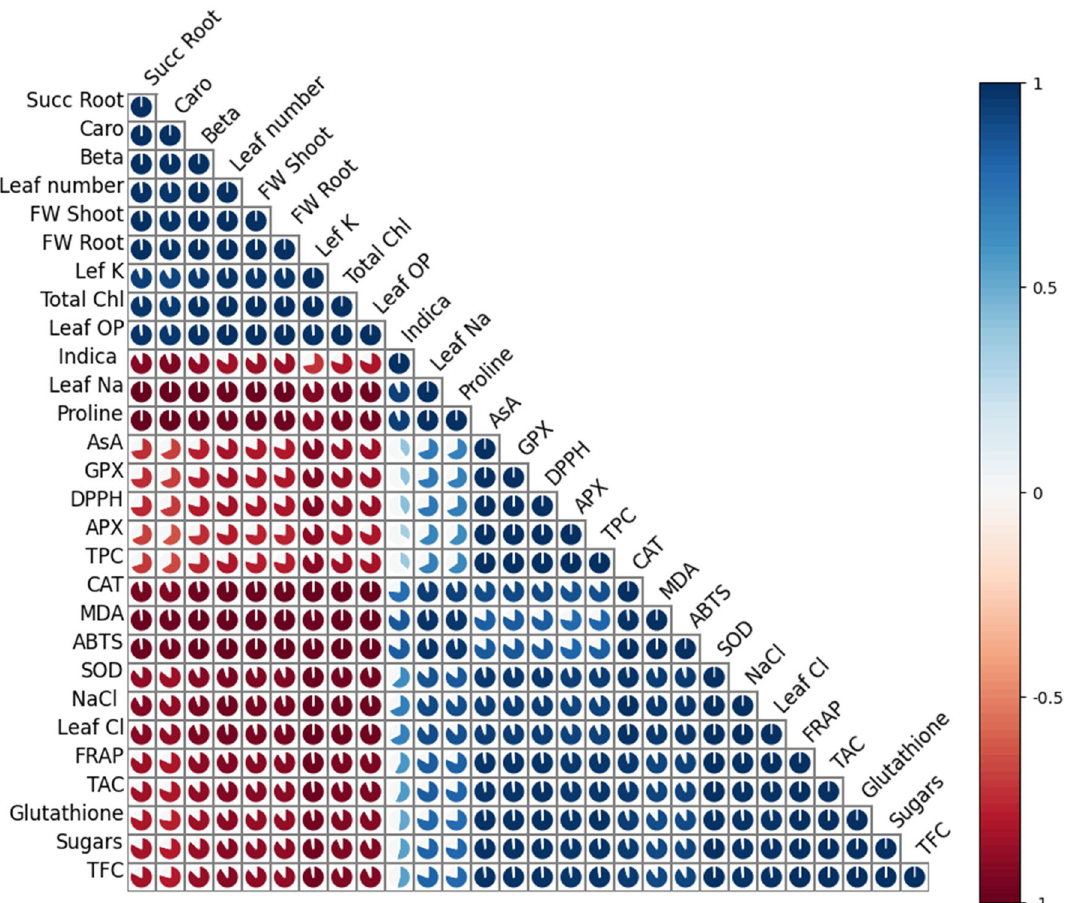
Figure 11. Heat map representing Pearson’s correlation among different traits of Moringa Oleifera by using R-software version